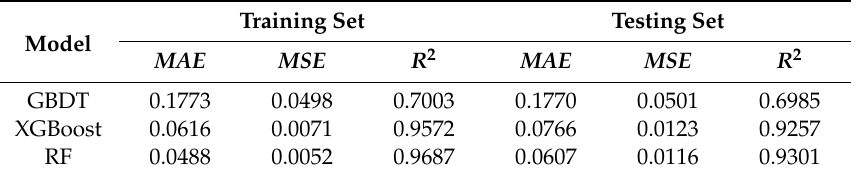
Table 4. Estimation models for protein content based on three algorithms.